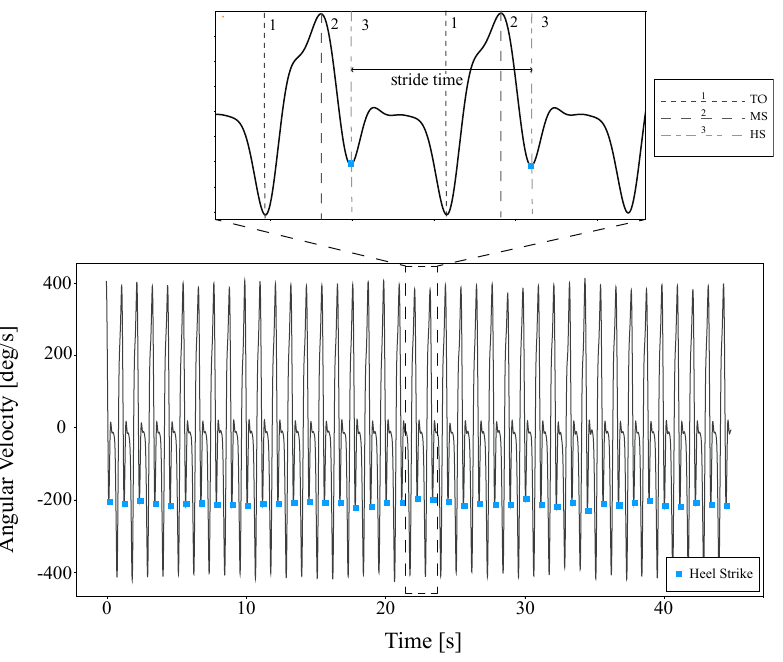
Figure 3. Heel strike detection using an inertial detection system on a participant’s test record. The zoom part represents two gait cycles and the identification of each gait phase: TO = Toe-Off (first dashed line), MS = Mid-Swing (second dashed line), and HS = Heel Strike (third dashed line).